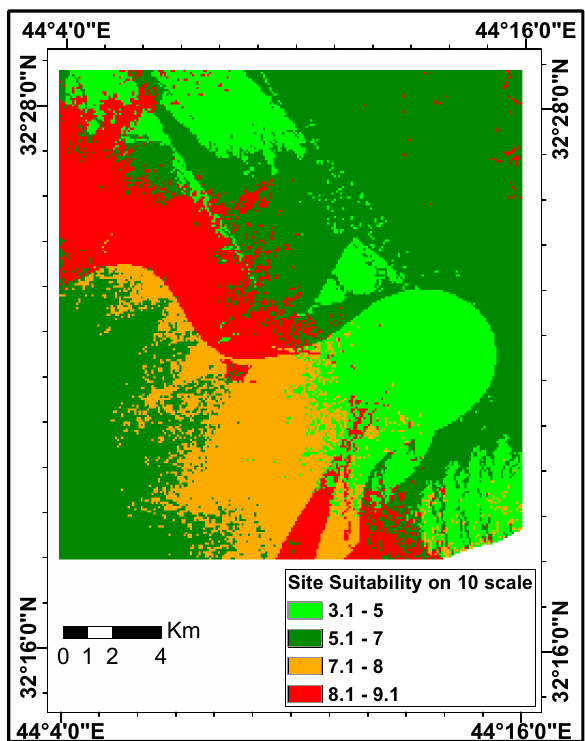
Figure 14. Site selection map for Karbala province—study area [11].